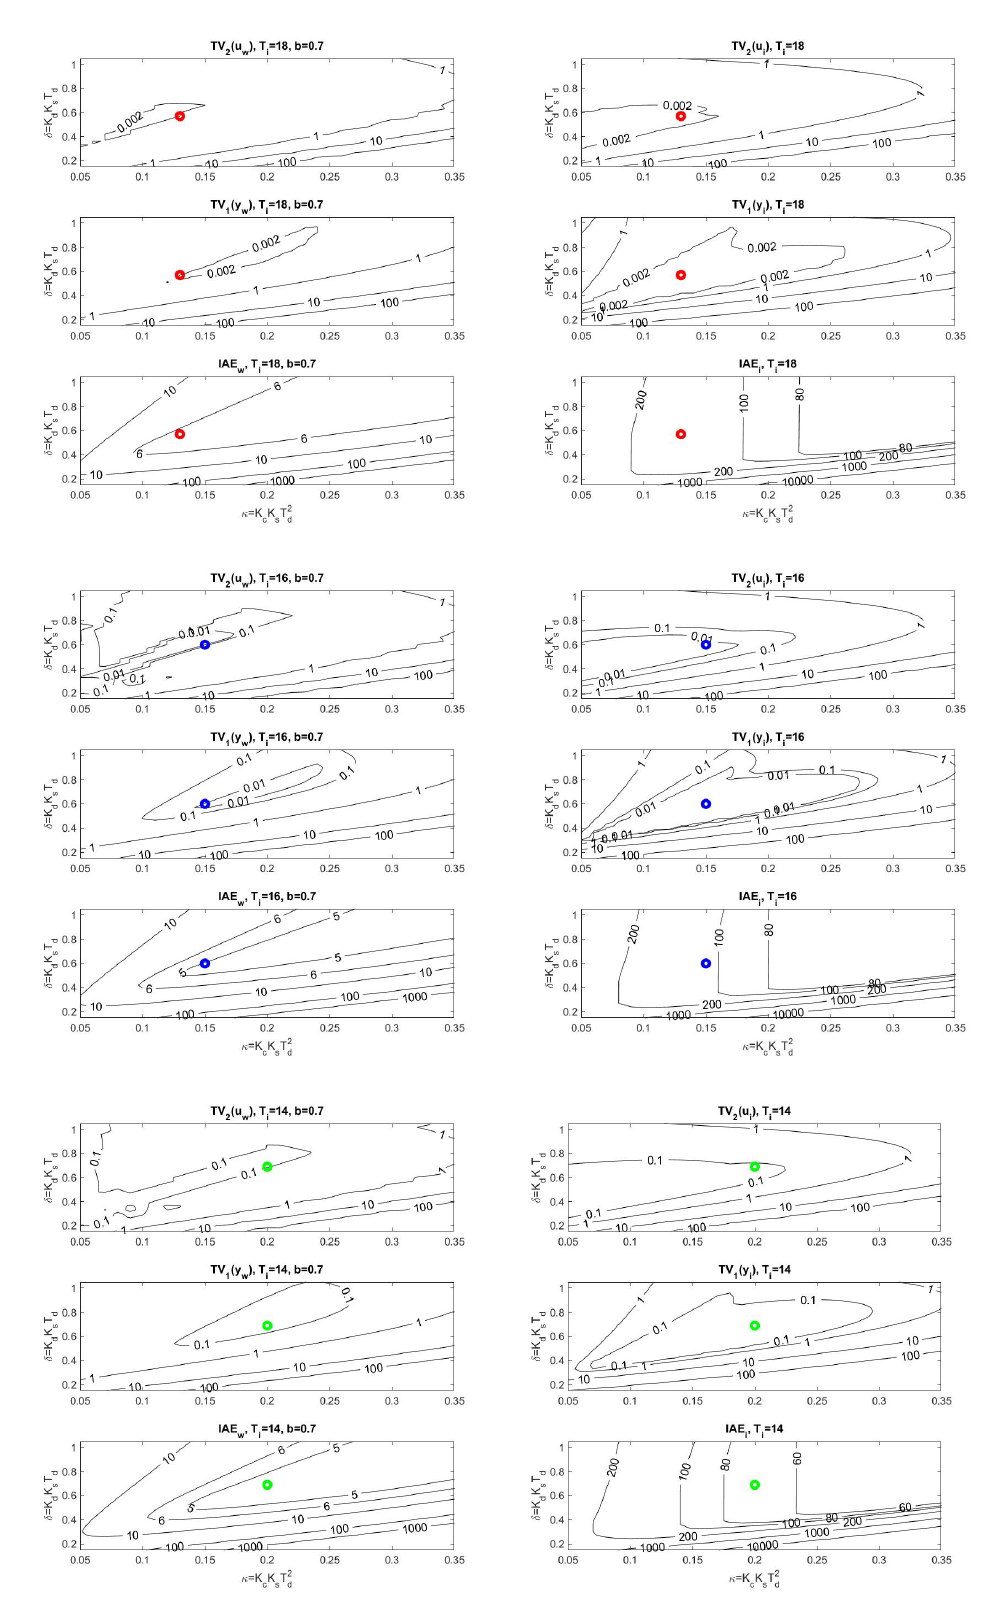
Figure 10. Cross-sections of PP (41) corresponding to setpoint responses ( left ) and disturbance responses ( right ) from Figure 8 for the optimal parameters (54) fulfilling the constraints (53) with (cid:101) = 0.002 (red, above), (cid:101) = 0.01 (blue, middle), and (cid:101) = 0.1 (green,